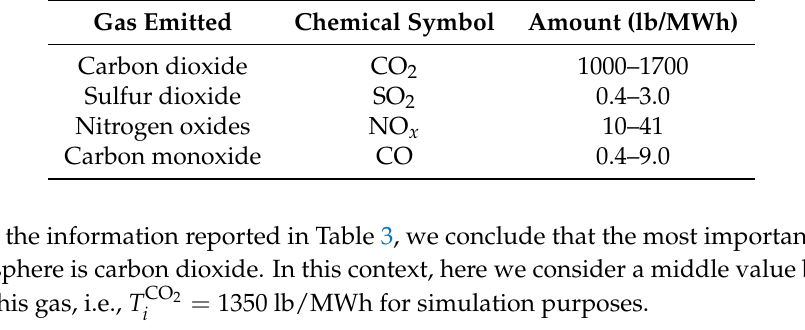
Table 3. Amount of main gasses emitted to the atmosphere by diesel